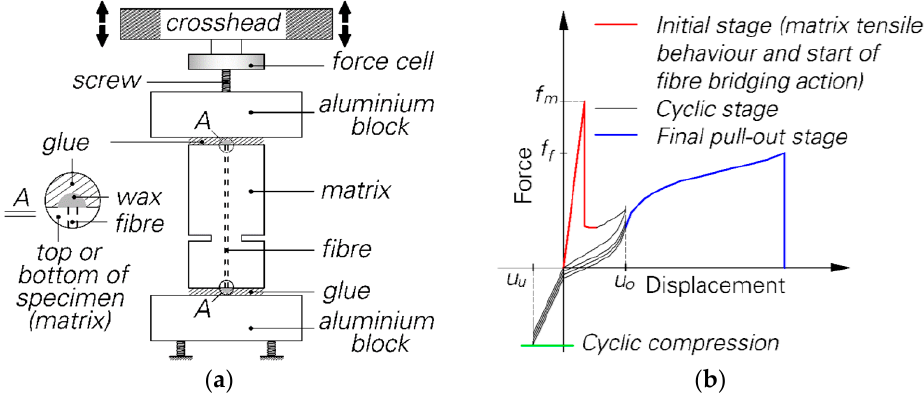
Figure 2. Double-sided, single fibre pull-out test: ( a ) testing setup [8]; ( b ) applied cyclic loading regime [9].